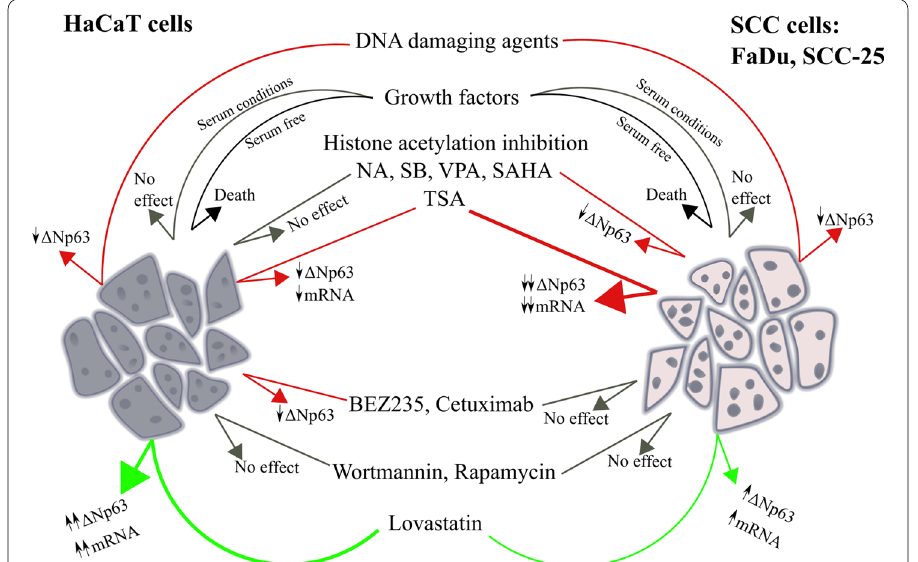
Fig. 7 Schematic representation of ΔNp63 regulation in non-transformed HaCaT keratinocytes versus FaDu and SCC-25 SCC cell lines. Green arrows indicate positive effects, red arrows indicate negative effects and gray arrows indicate no effect on ΔNp63 levels. Note that different agents show differences in the magnitude of induction or repression of ΔNp63 between non-malignant HaCaT cells and SCC